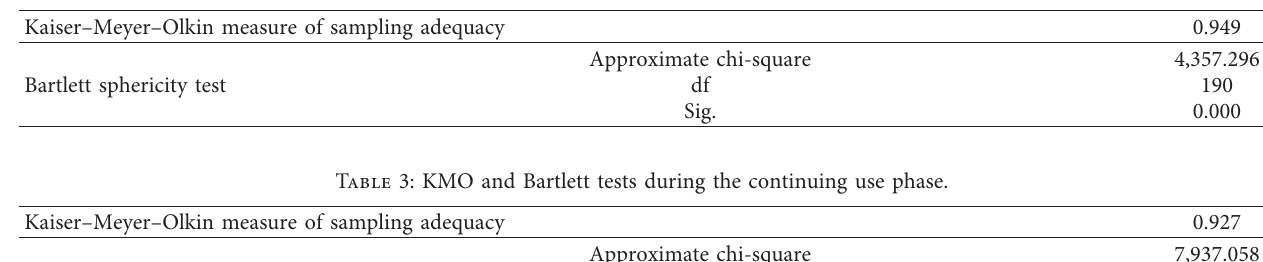
Table 2: KMO and Bartlett tests at the initial acceptance stage.